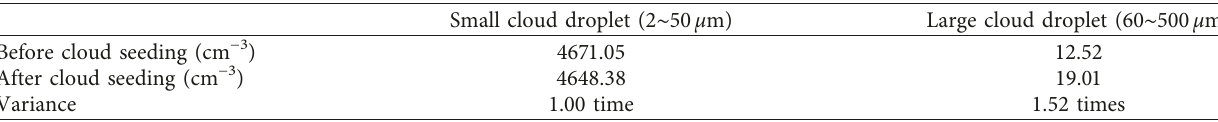
Table 3: Comparison of average cloud number concentration (cm − 3 ) between before and after cloud seeding at 1km height on April 25,